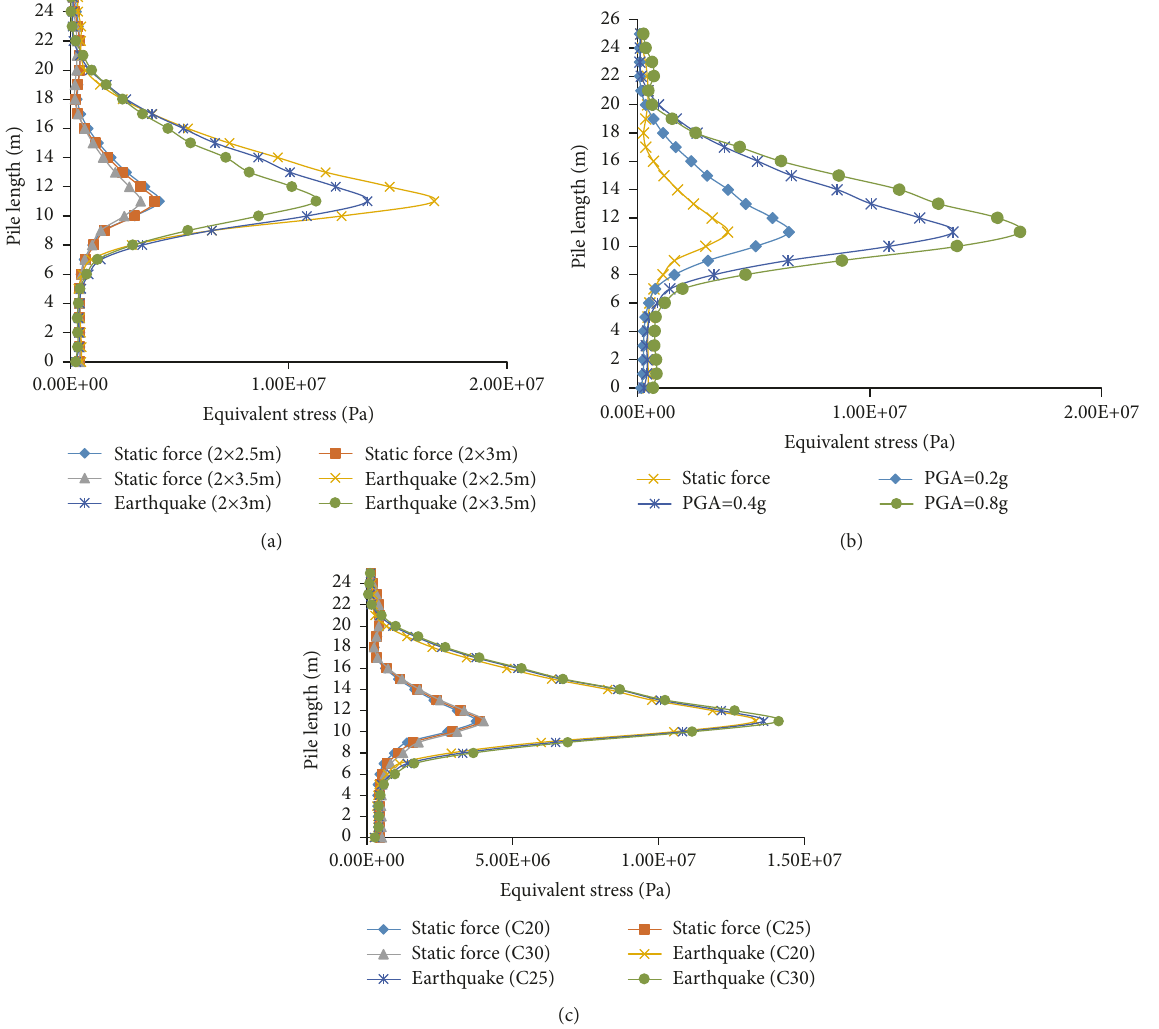
Figure 19: The equivalent stress curve of stabilizing pile in different working conditions. (a) Different section sizes; (b) different PGAs; (c) different material